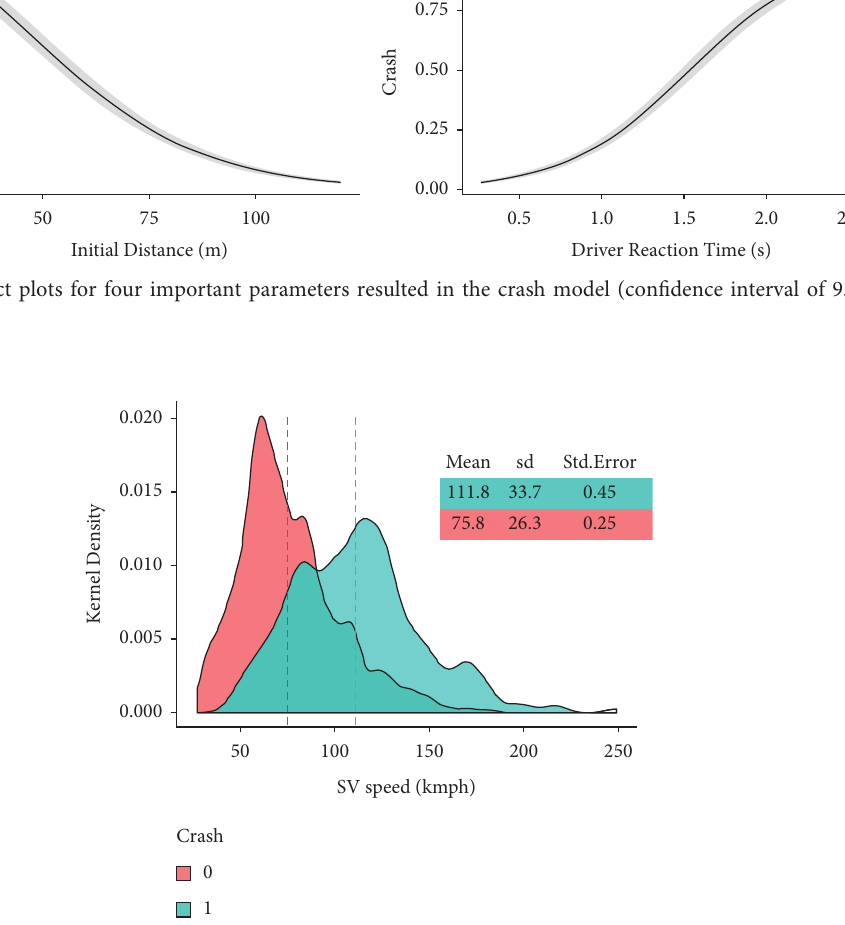
Figure 12: The kernel density estimate of SV vehicle’s speed equipped with AEB system (no crash: 0; crash occurred: